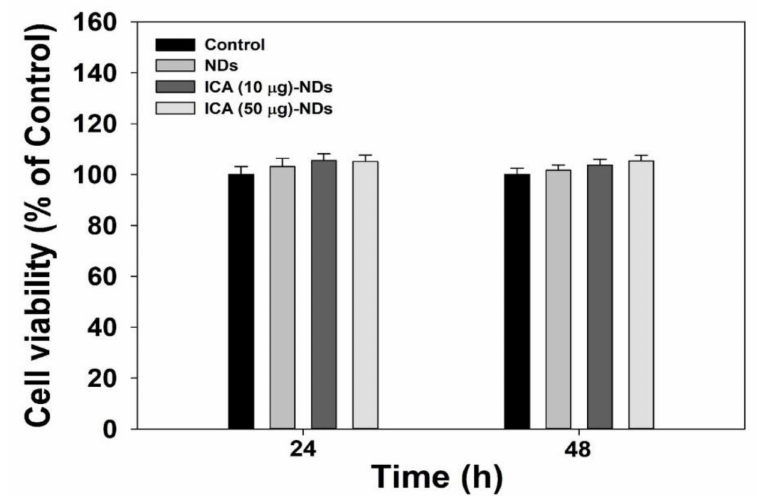
Figure 4. Cytotoxic e ff ects of NDs, ICA (10 µ g)-NDs, and ICA (50 µ g)-NDs on MC3T3-E1 cells ( n = 4 /